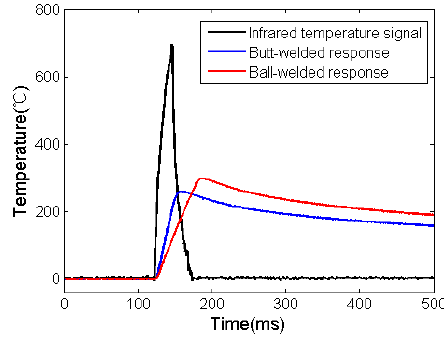
Figure 5. Output signal with two junction structures at 90% power.